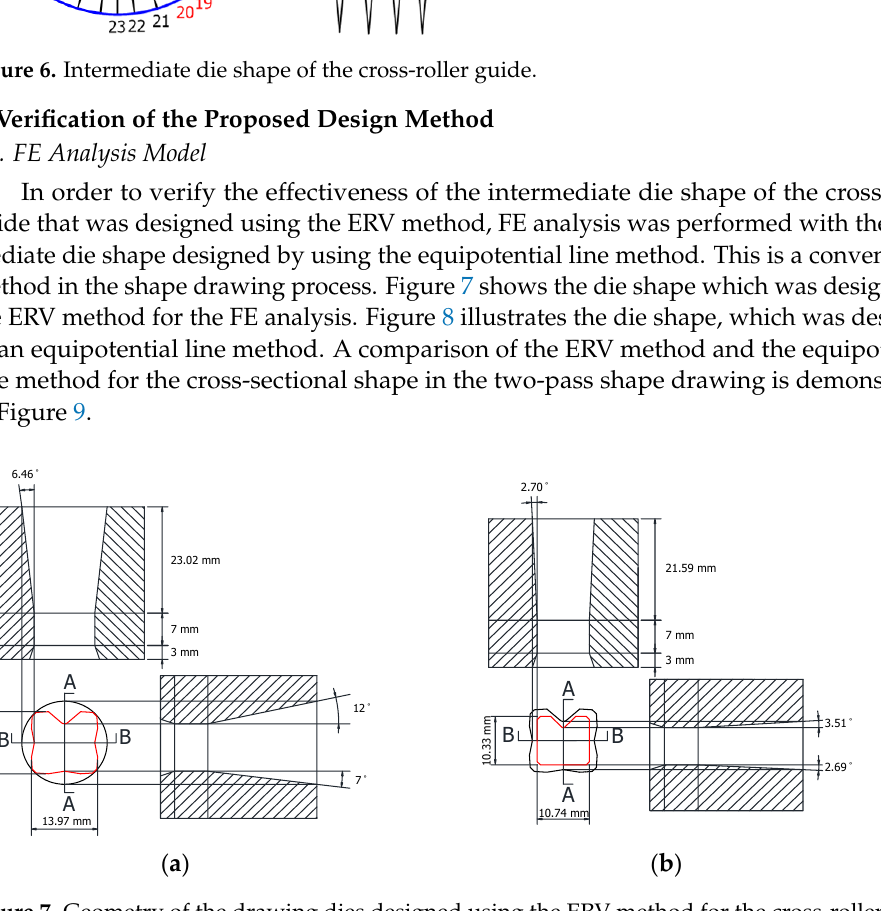
Figure 8. Geometry of the drawing dies designed using the equipotential line method for the cross- roller guide: ( a ) first pass; ( b ) second pass. Figure 9. Cross-sectional shapes of the two-pass shape drawing dies: ( a ) ERV method; ( b ) equipotential line method. The FE analysis was performed using the DEFORM-3D Ver.10.0 software (Columbus, Ohio, USA) environment. The initial material was AISI 1020 with an 18.2 mm diameter that was applied to the FE analysis in the two-pass shape drawing process, and initial temperature was considered as room temperature. The flow stress equation of the annealed material was used in the shape drawing experiment as described in Equation (8):